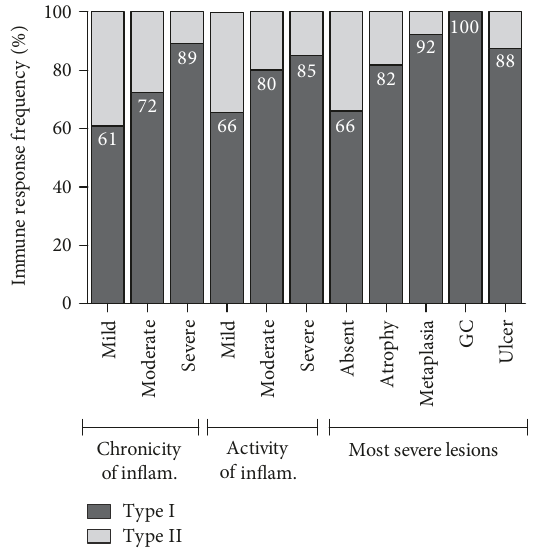
Figure 4: Association between the type of serological response (I/II) and the fi ndings in histology analysing H. pylori positive cases. The presence of an immune response against H. pylori virulence factors CagA/VacA indicates a type I infection, and these are de fi ned as the high-risk group. The chronicity and activity are categorized as mild, moderate, and severe. Most severe lesions are categorized as absent, atrophy, intestinal metaplasia, ulcer, and gastric cancer according to histology. The proportion of type I immune response increases with higher degrees of chronicity and activity of gastritis ( p = 0 02 and p < 0 01 , resp.). There is a signi fi cant increase in the portion of type I immune response if signs of advanced pathology are present in histology ( p < 0 01